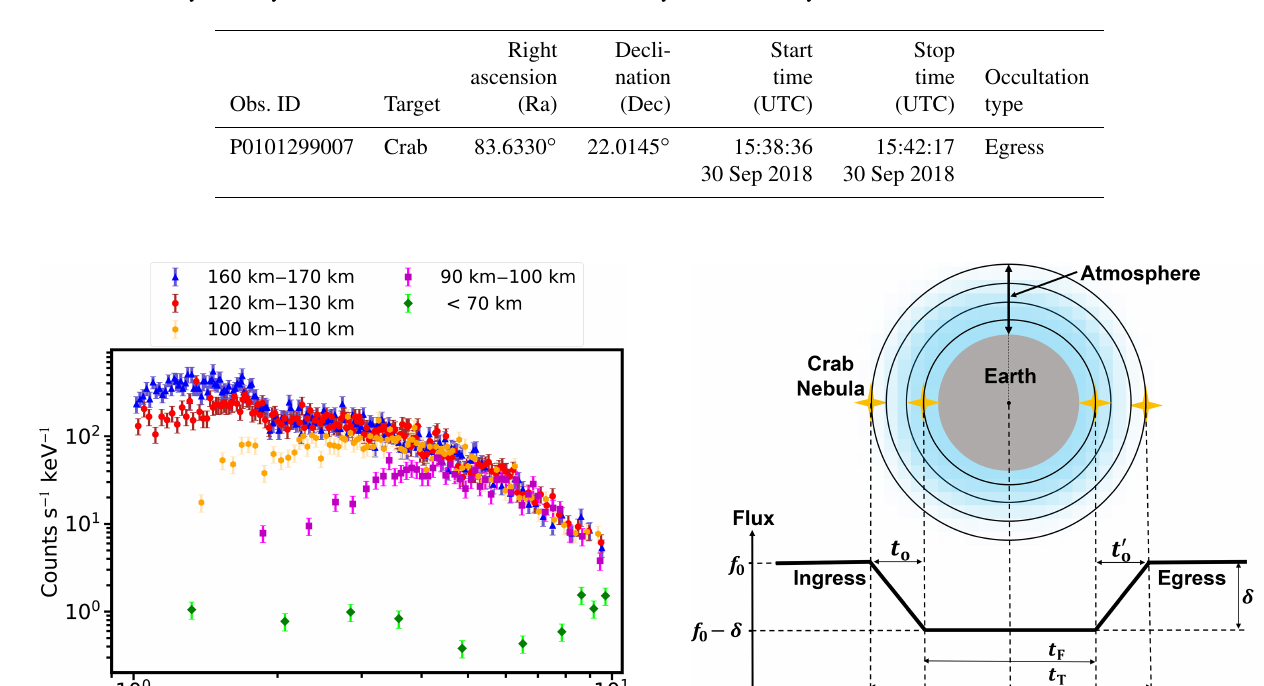
Table 1. Summary of X-ray Earth occultation of the Crab Nebula analysed in this study.